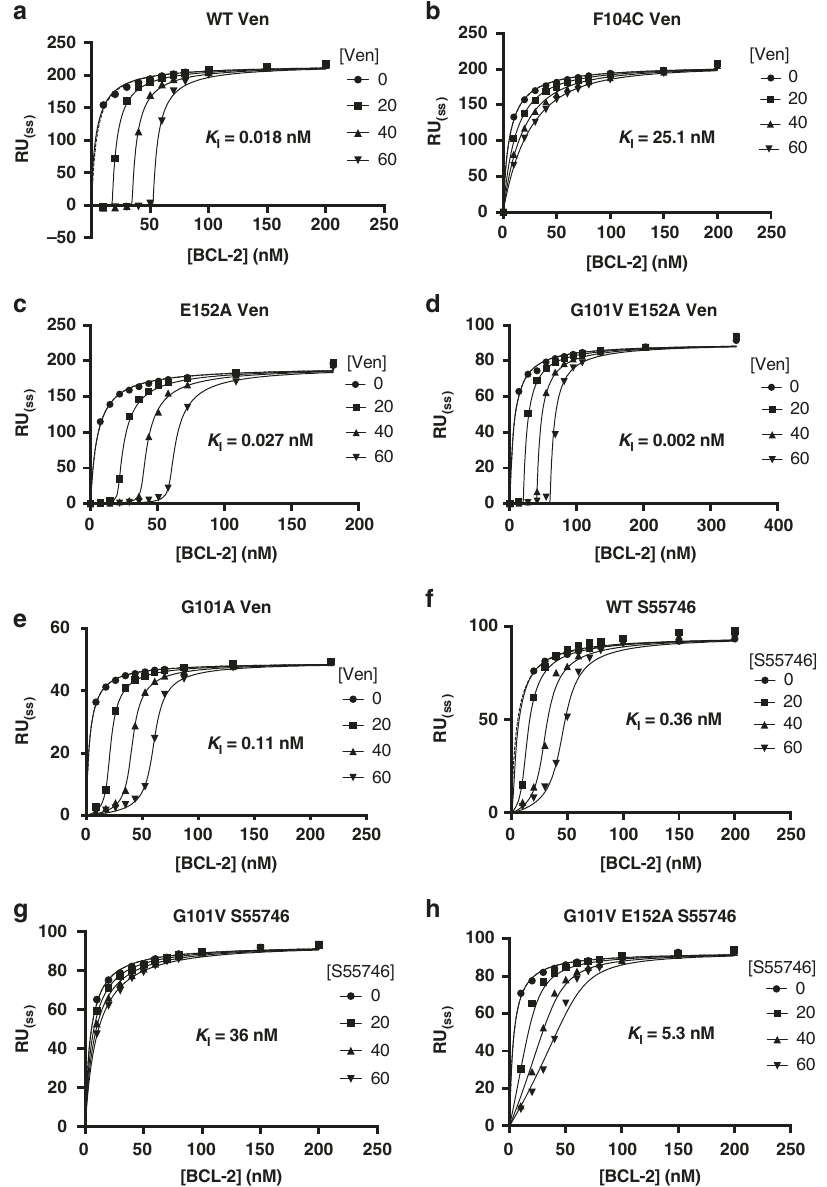
Fig. 3 Steady-state competition SPR with BCL-2 mutants, BIMBH3 and venetoclax or S55746. SPR chip surfaces were immobilised with BIMBH3 peptide and analytes with the indicated BCL-2 mutants pre-combined with either a – e venetoclax (Ven) or f – h S55746 at the indicated concentrations (circles 0 nM, squares 20 nM, triangles point up 40 nM, triangles point down 60 nM). Response at steady-state is plotted against BCL-2 concentration, with fi ts from a steady-state competition SPR model shown (see methods and Supplementary Figs. 5, 6 for further details), that were used to derive the indicated mean K I values for venetoclax or S55746 binding to BCL-2. Data are representative of at least n = 2 independent